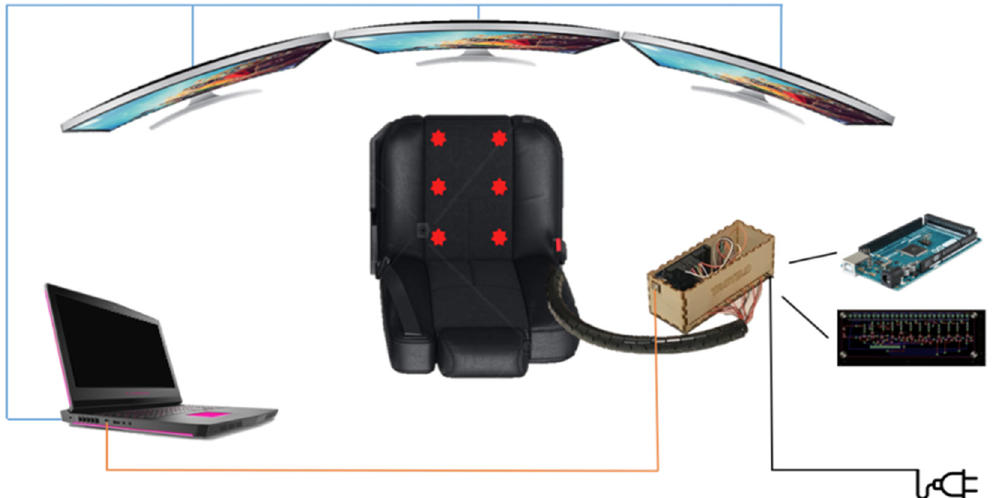
Figure 4. Hardware setup of the driving simulator consisting of three simulation monitors ( top ), the driver’s seat with the advanced driver assistance system (ADAS) embedded in the seat cover as viewed from above ( central ), the simulation computers ( left ) and the ADAS control unit consisting of a microcontroller, Printed Circuit Board (PCB), and wiring ( right ).